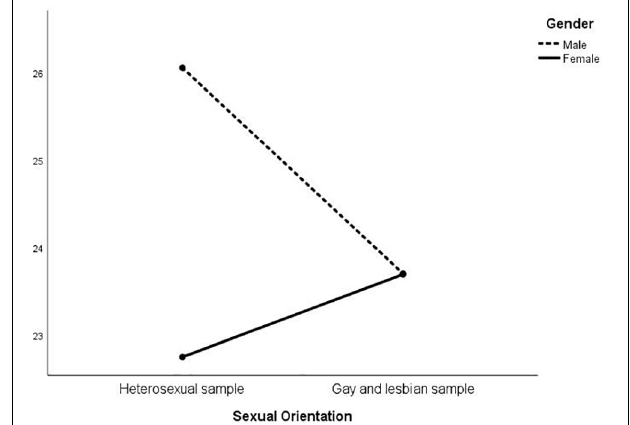
FIGURE 1 | Interaction of gender × sexual orientation on EIQ F1-Trasgressive